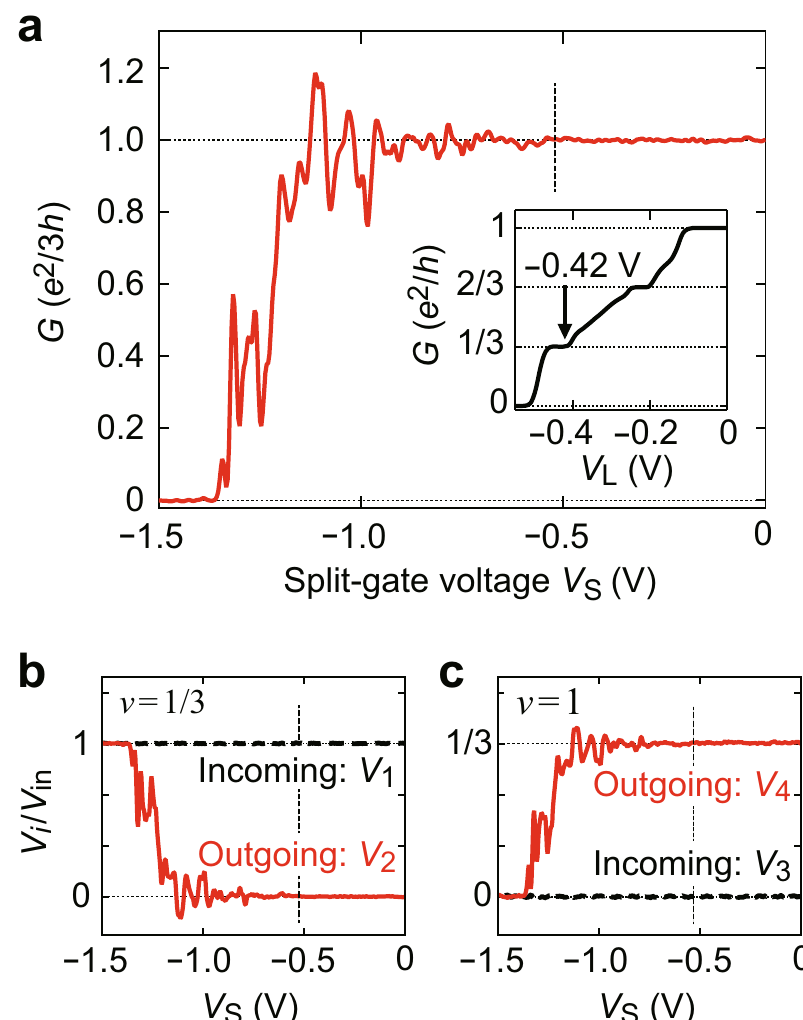
Fig. 2 Signatures of Andreev re fl ection. a Two-terminal conductance G as a function of split-gate voltage V S , taken with V L = − 0.42 V. Below V S ≅ − 0.55 V (indicated by a dashed line), the 2DESs underneath the split gate electrodes are depleted to form a narrow 1/3-1 junction. Conductance oscillations with G > e 2 /3 h , the evidence of the Andreev re fl ection, are observed. (Inset) G as a function of leftmost top gate voltage V that a v = 1/3 state forms at V L = − 0.42 V in the region immediately to the left of the junction (red region in Fig. 1a, b). b , c V S dependence of the voltages on the incoming ( V 1 and V 3 ) and outgoing ( V 2 and V 4 ) channels, measured in the same setup as in ( a ) on the v = 1/3 ( b ) and v = 1 ( c ) sides of the junction. The vertical axes are normalised by the source-drain voltage V in . Both negative output ( V 2 < 0) in the re fl ected channel and overshoot ( V 4 > V in /3) in the transmitted channel are the signatures of the Andreev re fl